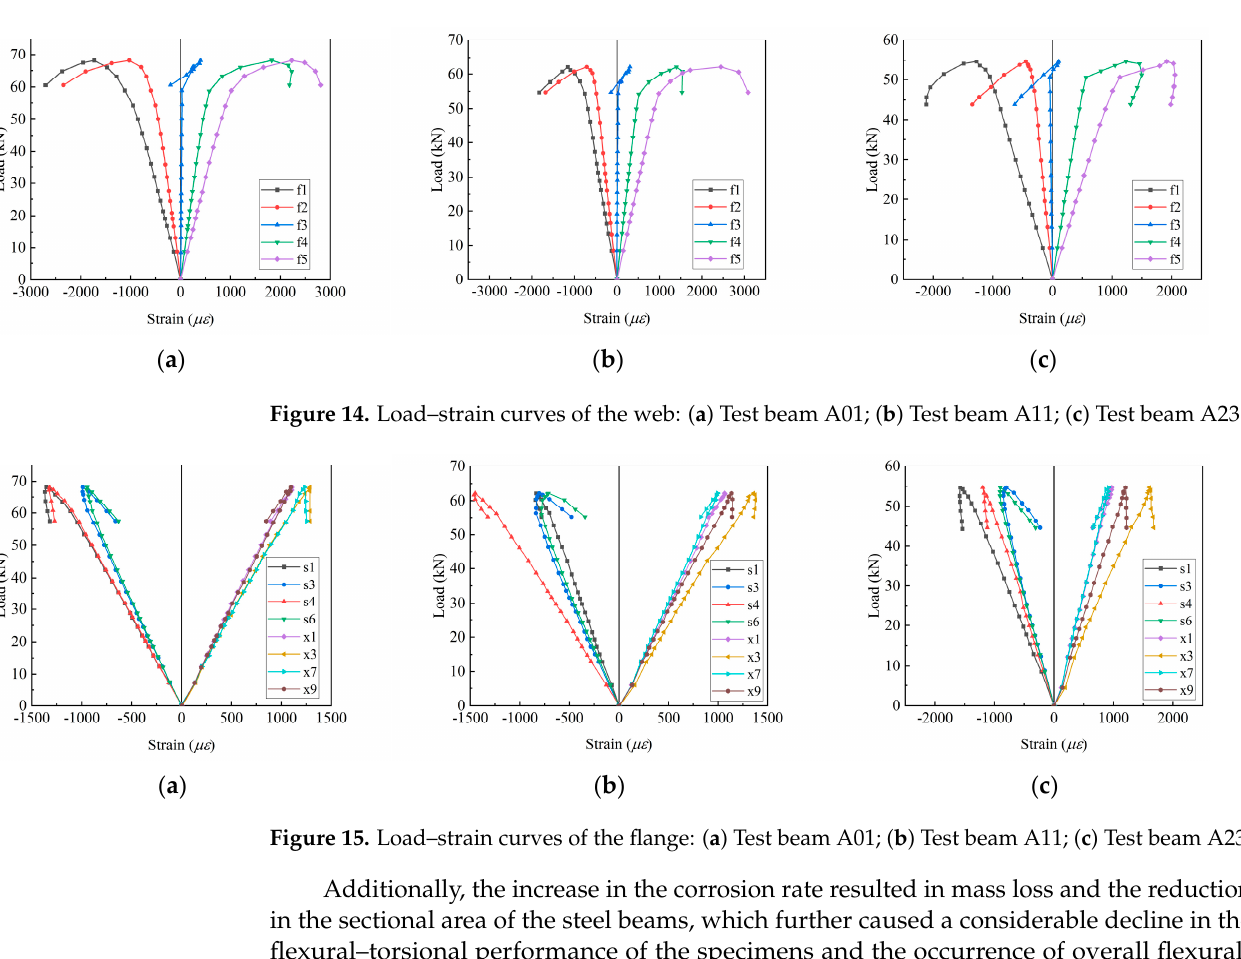
Figure 16. Finite element mesh division.